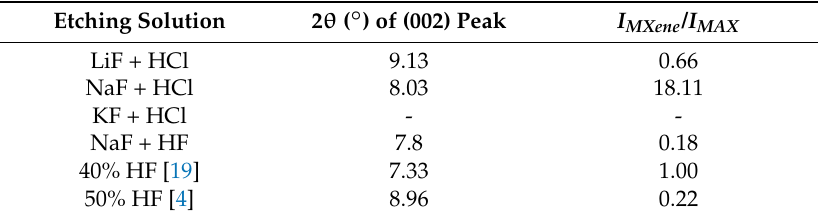
Table 2. 2 θ ( ◦ ) of the (002) peak of newly formed V 2 C by different methods and the intensity ratio of